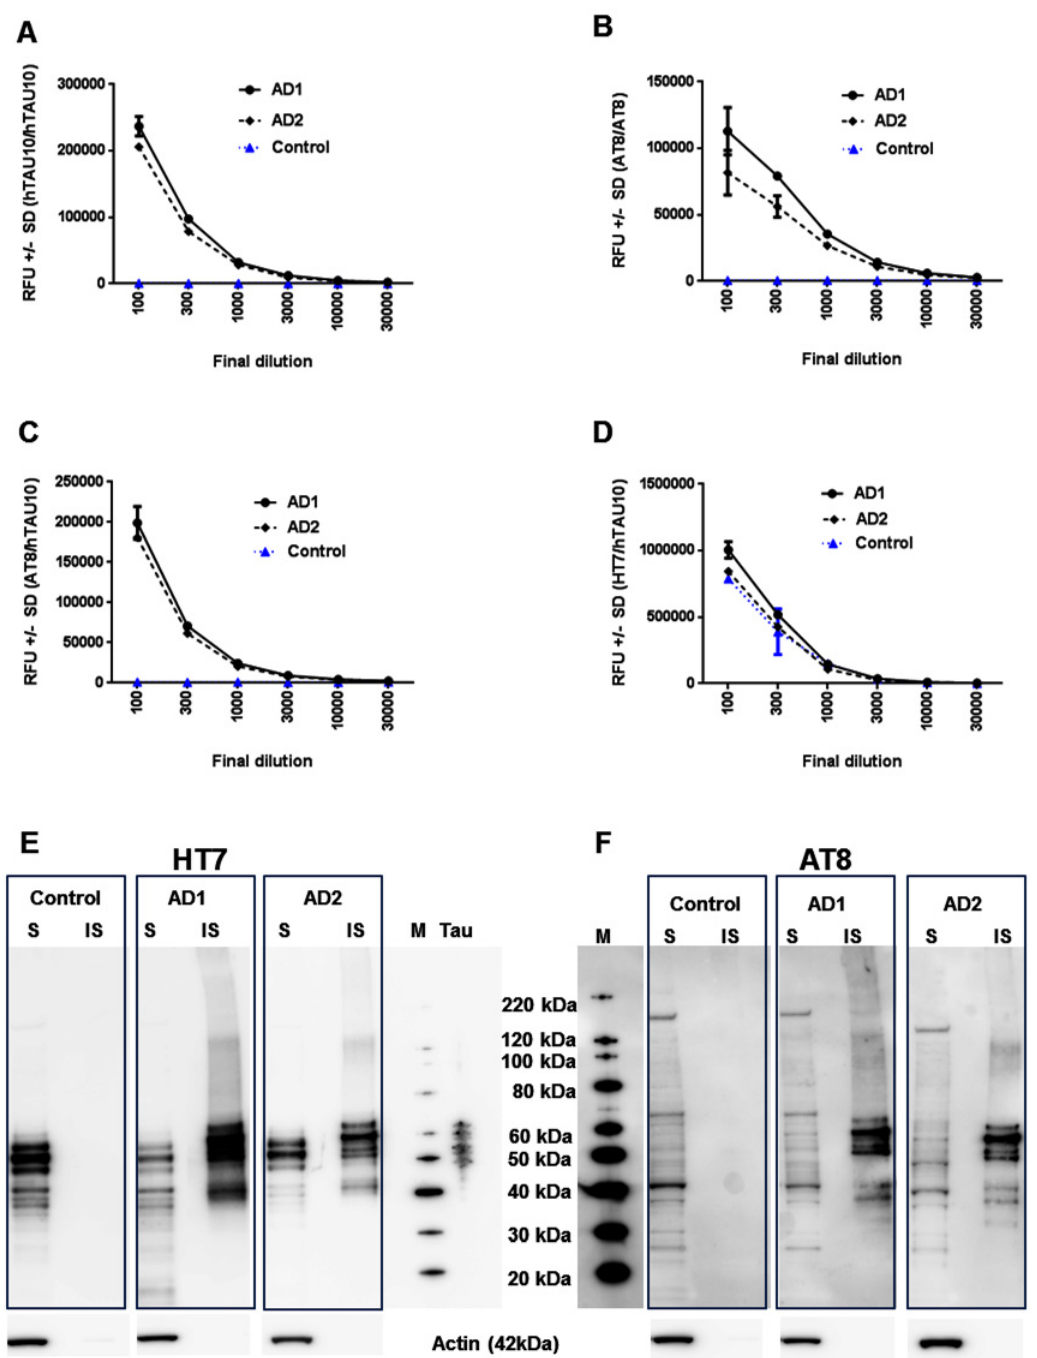
Fig 2. AlphaLISA optimizations on human brain extracts for total TAU, TAU aggregation and phosphorylation. (A, B) AlphaLISA on 2 different AD brain extracts show high hTAU10 (A) and AT8 (B) TAU aggregation signals compared to control brain samples. (C, D) AT8/hTAU10 (C) AlphaLISA on these AD brain extracts reveals high levels of phosphorylated TAU compared to control brain samples while both AD and control brain extracts display high HT7/ hTAU10 (D) levels. Decreasing signals with increasing dilutions suggest no hooking of the samples. Representative curve of 1 experiment with 2 technical replicates is shown as RFU (relative fluorescence units) ± SD. (E, F) Western Blot on soluble (S) and insoluble (IS) fractions of control and AD brain extracts after Sarkosyl extraction shows HT7-positive (E) and AT8-positive (F) bands only in the Sarkosyl insoluble pellets of both AD patients, confirming the presence of TAU aggregates. M represents Magic Marker (band sizes) and T represents TAU ladder with all 6 TAU isoforms. All experiments have been confirmed at least twice.